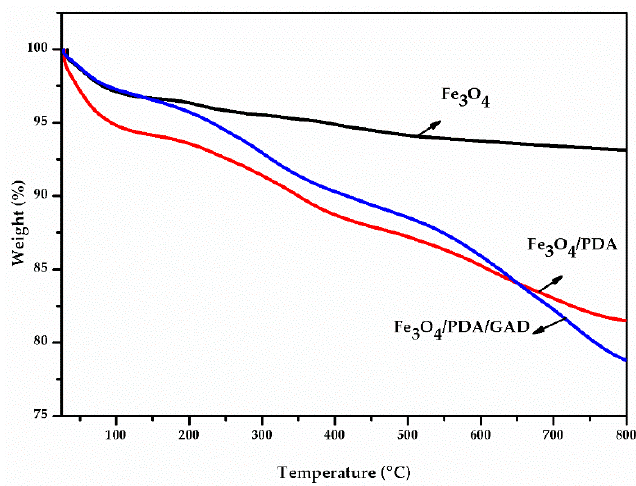
Figure 3. TGA curves of Fe 3 O 4 , Fe 3 O 4 / PDA, and Fe 3 O 4 / PDA / GAD.